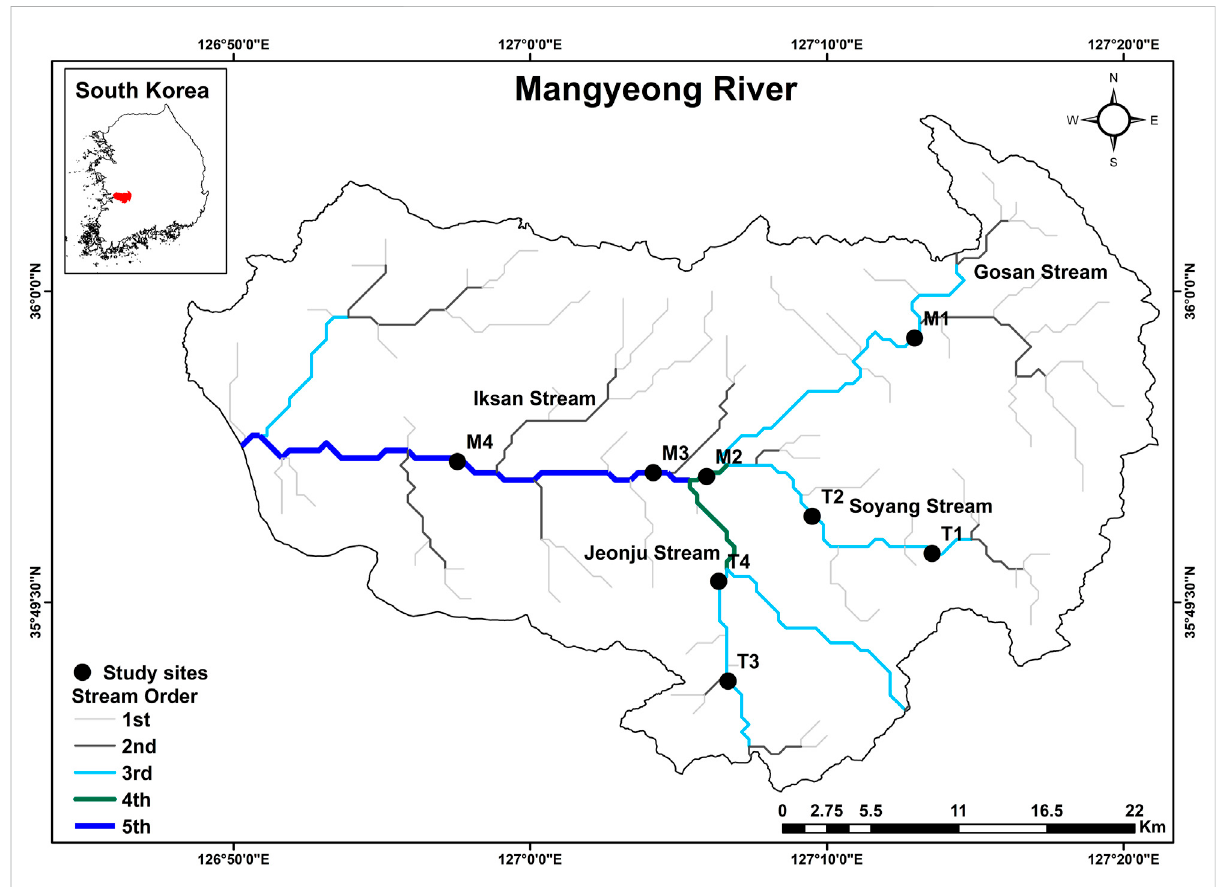
FIGURE 1 Mangyeong River watershed and the locations of the eight study sites, showing stream